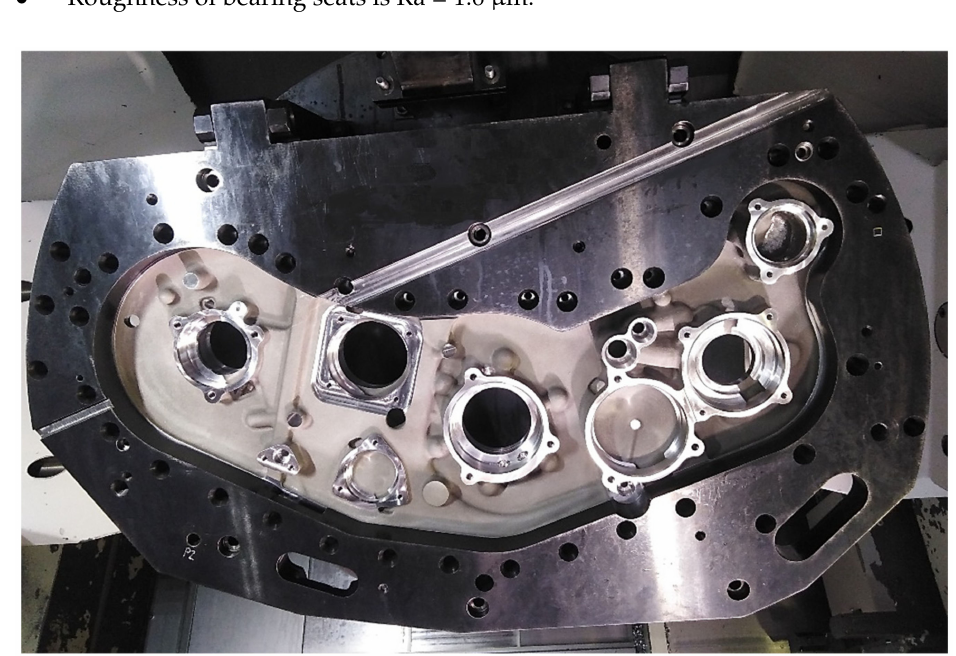
Figure 4. ADT casing cover in a fixture in a CNC machine—view from the bearing seat